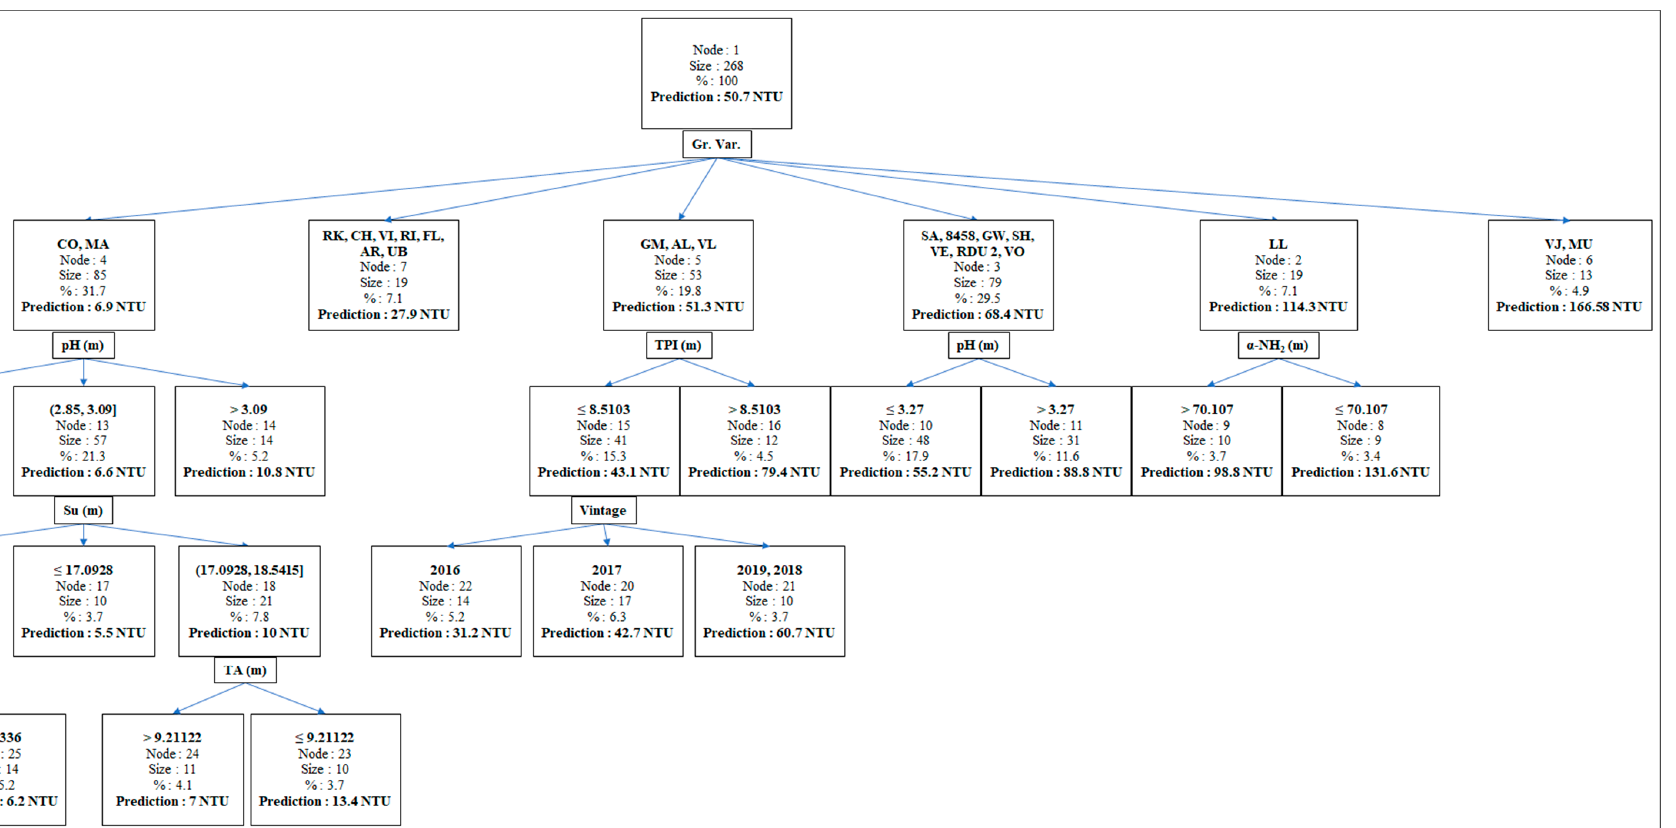
Figure 3. Classification and regression tree carried out with all the oenological parameters measured in the musts and wines and the “grape variety” and “vintage” quality variables. “Prediction” is the average protein instability ( Δ NTU) calculated for each class. Gr. Var.: Grape Variety; CO: Colombard; MA: Mauzac; RK: Rkatsiteli; CH: Chardonnay; VI: Viognier;